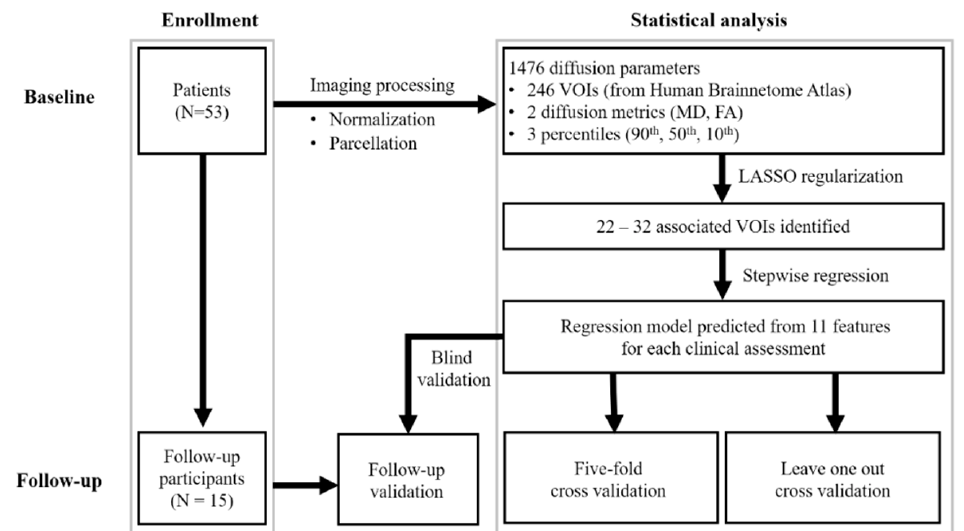
Figure 1. Flowchart of study design. VOI, volume of interest; UPDRS-III, motor subscale of Unified Parkinson’s Disease Rating Scale; PIGD, postural instability and gait disorder staging; MHY, modified Hoehn and Yahr staging; LEDD, levodopa equivalent daily dose.